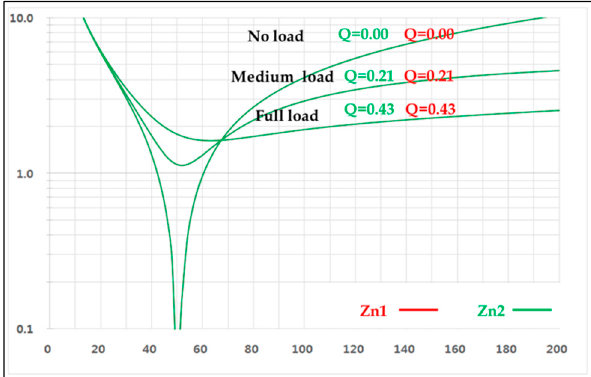
Figure 16. Characteristics of input output voltage gain and frequency of the proposed converter.